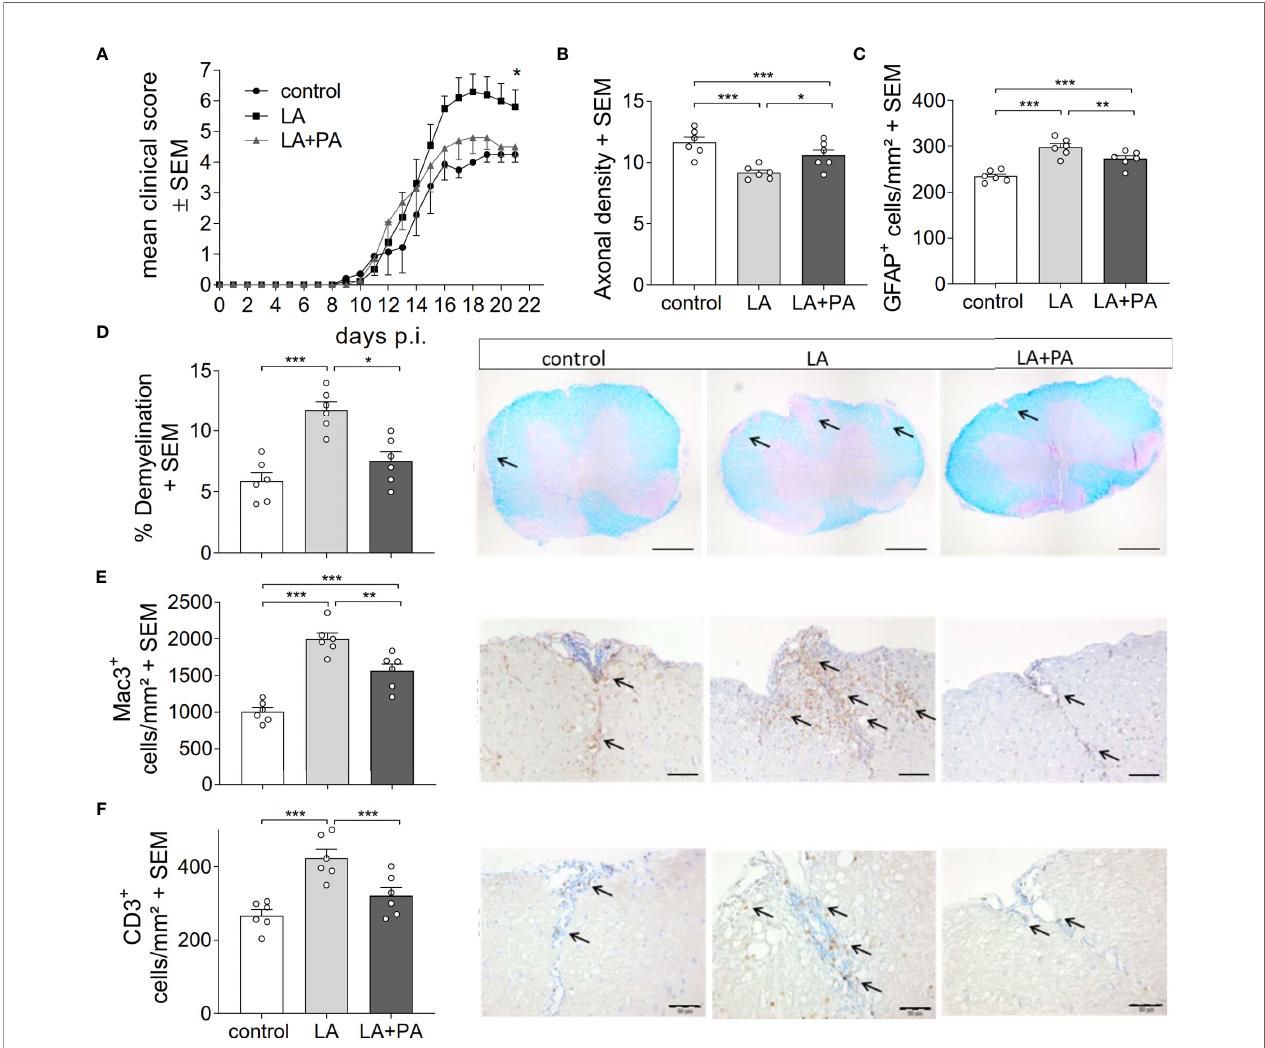
FIGURE 1 | PA reverts the deleterious effect of a LA-rich diet in MOG-EAE. (A) Clinical course of MOG 35-55 -EAE. Mice were fed a LA-rich diet or control-diet 4 weeks prior to immunization and were additionally treated with PA (LA+PA, 150mM) or water (control; LA) by daily oral gavage starting from day 0. Data are shown on a 10-point score scale as mean ± SEM and are pooled from two independent experiments (control n=11, LA n=11, LA+PA n=12). (B – F) Histological analysis of spinal cord cross sections on day 21 of EAE. (B) Axonal density was analyzed by Bielschowsky silver staining. (C) Analysis of GFAP+ astrocytes. (D) Demyelination was analyzed by LFB-PAS staining. (E) In fi ltration of macrophages (Mac-3) and (F) CD3 positive T cells are reduced in LA-diet mice treated with PA compared to control treated animals. Representative pictures are shown for each staining and group. Scale bars are 500 µm for LFB-PAS and 50 µm for Mac-3 and CD3. Arrows indicate CD3+ cells, Mac3+ cells or demyelinated area. n=6 mice per group. *p<0.05 using Kruskal-Wallis test for (A) , *p<0.05, **p<0.01, ***p<0.001 using one-way ANOVA and Tukey ’ s posthoc test for (B – D) . p.i., post immunization; LA, lauric-acid diet; PA, propionic